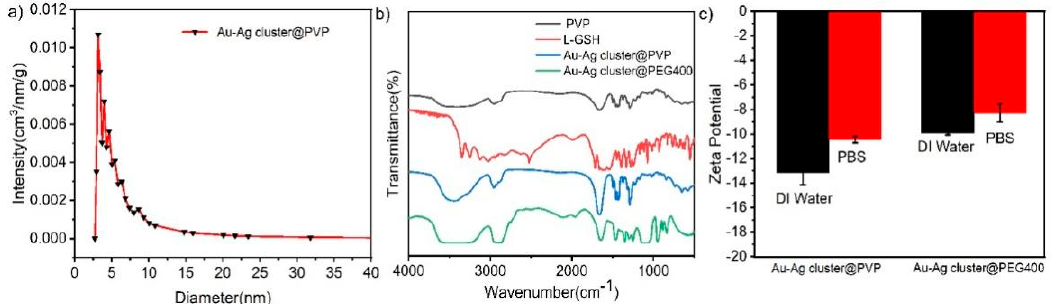
Figure 3. ( a ) Pore size distribution curves of assembled heterogeneous Au-Ag NCs; ( b ) Powder FT-IR spectra of Au-Ag cluster @PVP and Au-Ag cluster @PEG400, respectively; ( c ) Zeta potential values of Au-Ag cluster @PVP and Au-Ag cluster @PEG400, which were incubated in PBS and water medium, respectively.